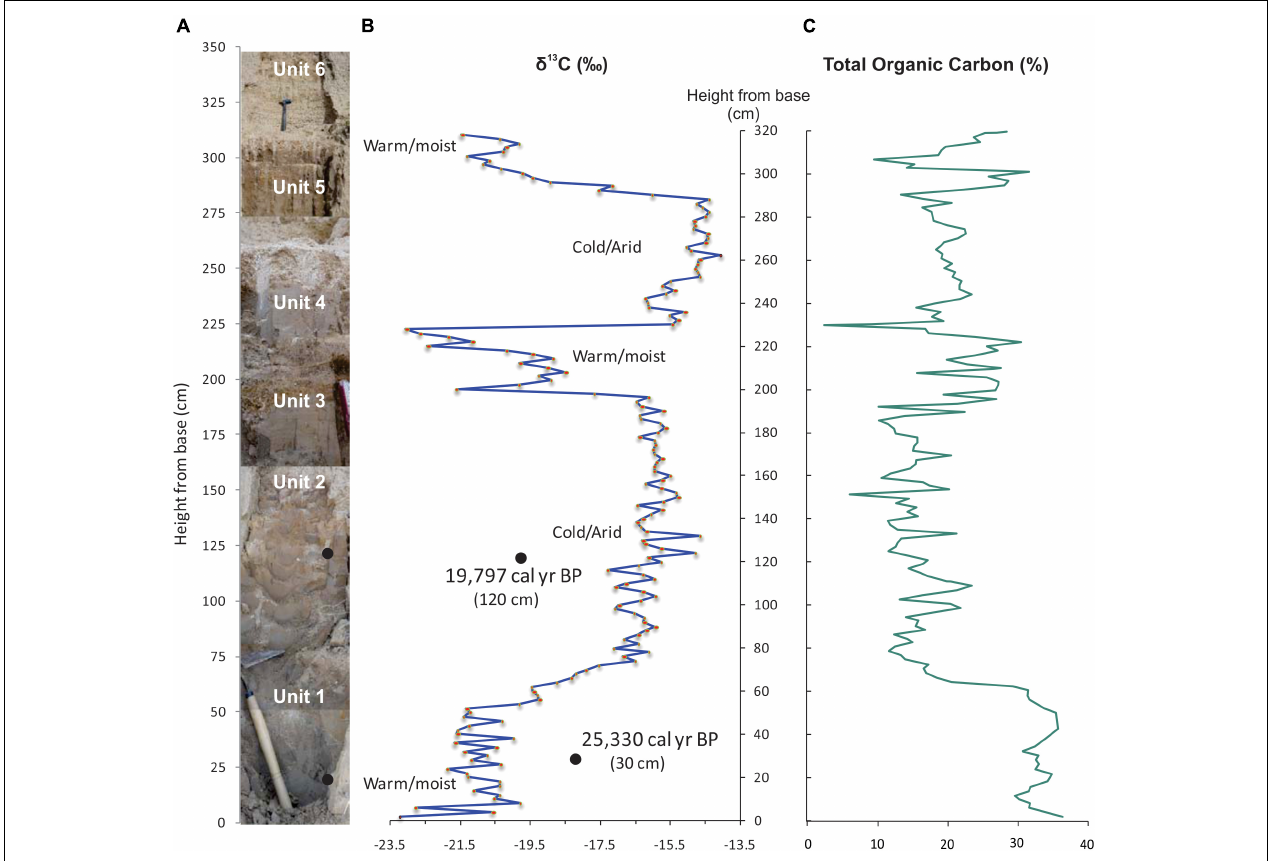
), and (C) total organic carbon (cid:104)